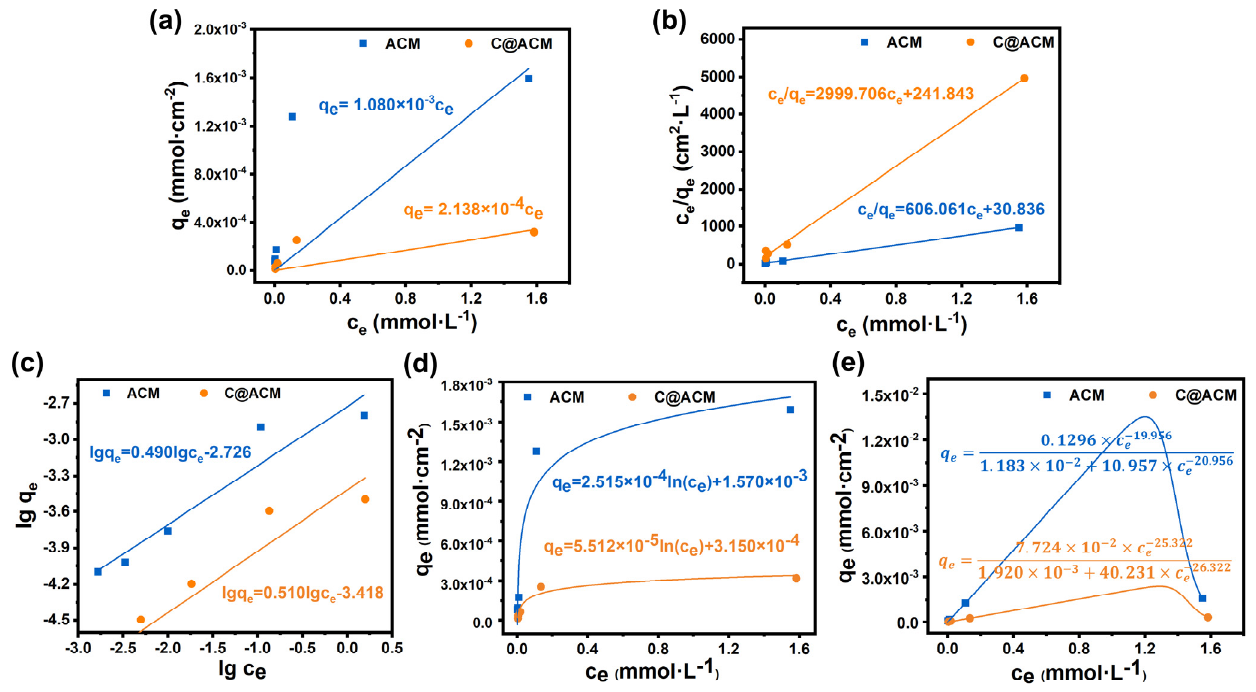
Figure 8. Adsorption isotherms of ACM and C@ACM: ( a ) Henry; ( b ) Langmuir; ( c ) Freundlich; ( d ) Tempkin; ( e ) Radke–Prausnitz models. Table 5. Isotherm parameters for H + adsorption.